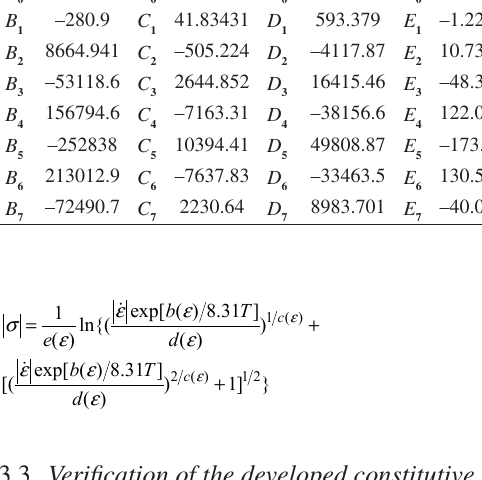
Table 1. Polynomial fitting results of Q , n , ln A and α of as-casting AZ80 magnesium alloy. Q n ln A α 127.6204 C B 0 –280.9 C B 1